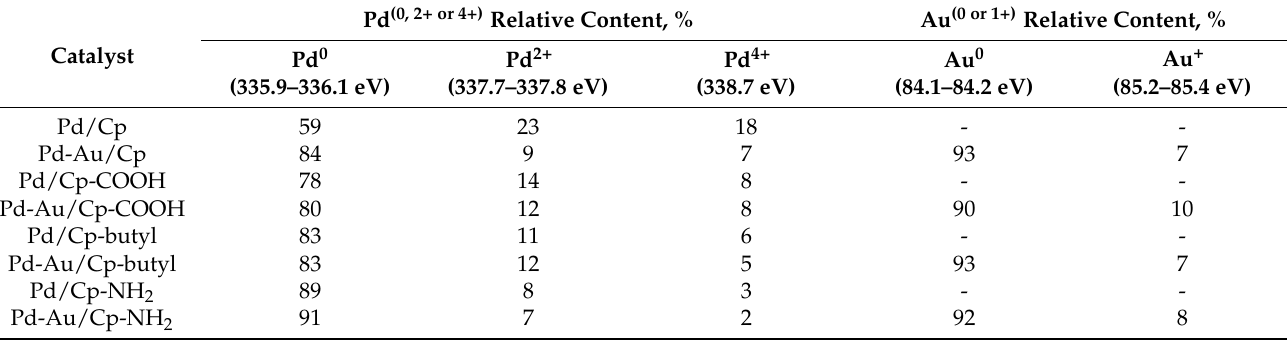
Table 5. Effect of support modification on the contribution of different electronic states of Pd and Au on the catalyst surface calculated according to XPS.